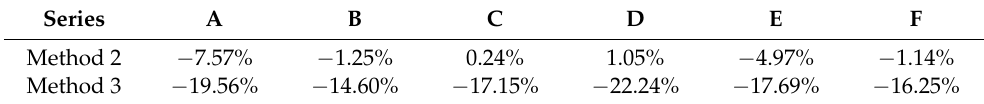
Table 1. Relative differences between the values calculated by methods 2 and 3 in respect to method